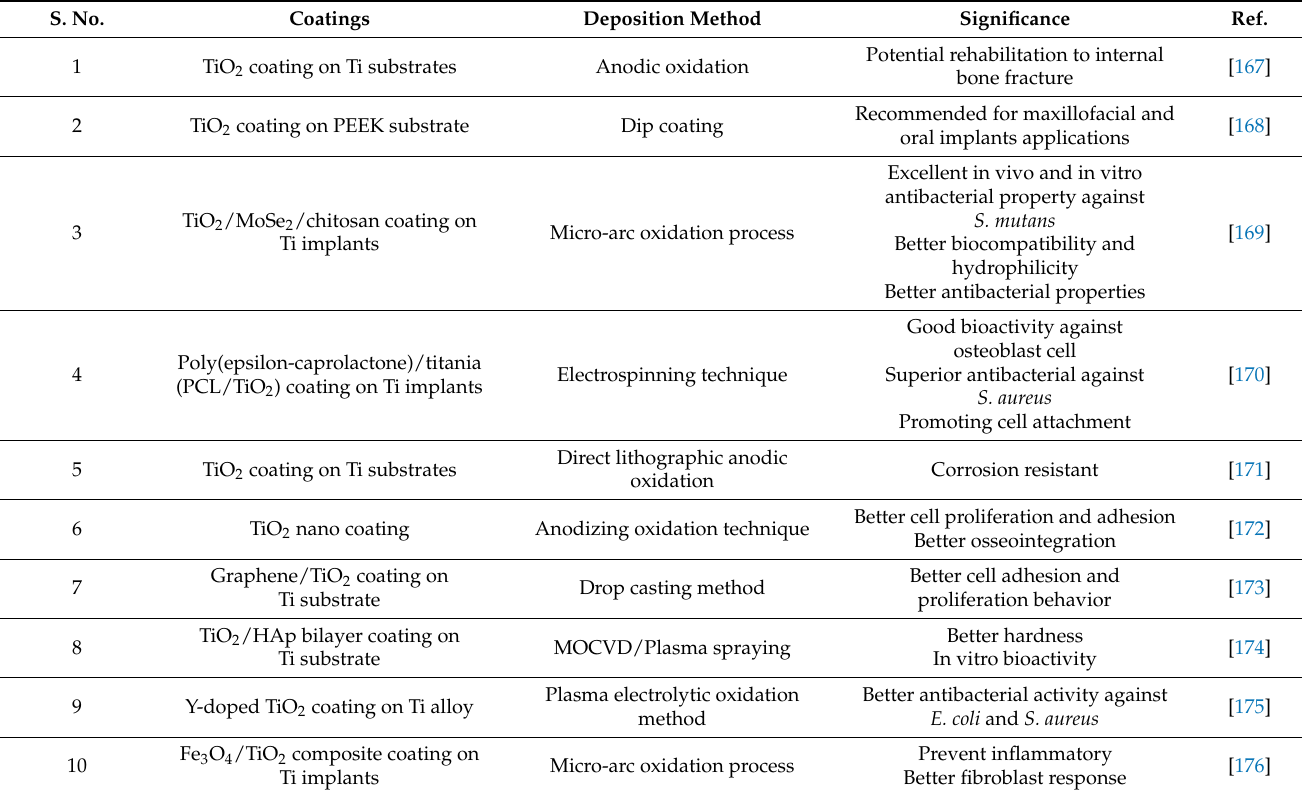
Table 4. Uses of TiO 2 and its composite coatings in bioimplant